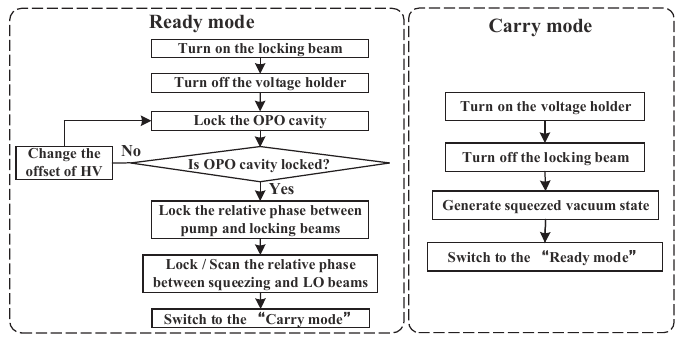
Figure 2. Block diagram of the FPGA-based algorithm. LO, local oscillator; HV, high